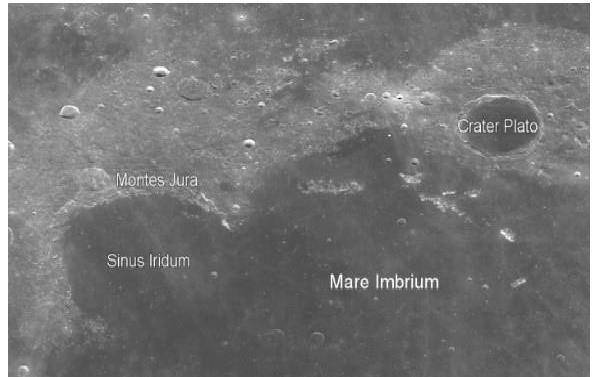
Figure 1. DOM of the experimental area